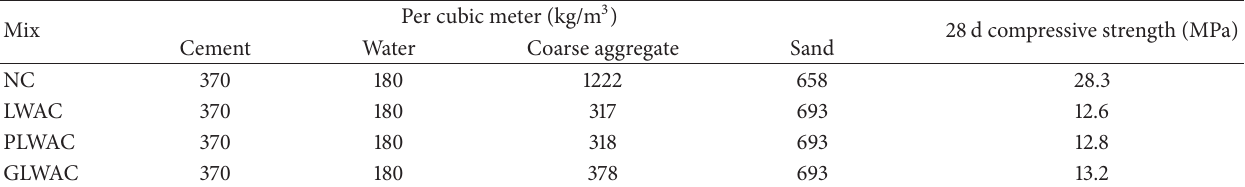
Table 3: Mix proportions.